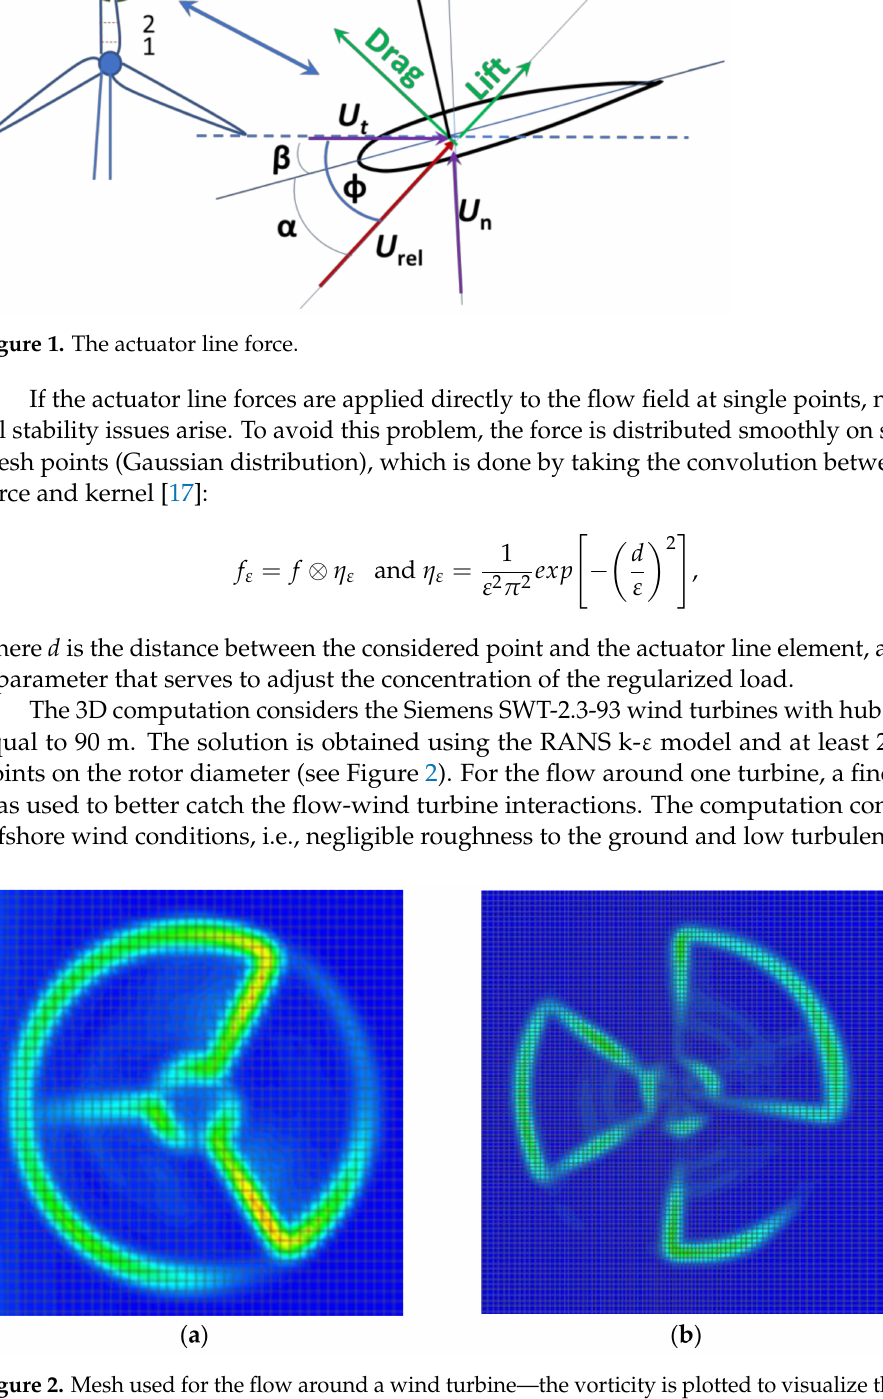
Figure 2. Mesh used for the flow around a wind turbine—the vorticity is plotted to visualize the rotor and the grid points on it: ( a ) mesh on the rotor; ( b ) finer mesh used around a single wind